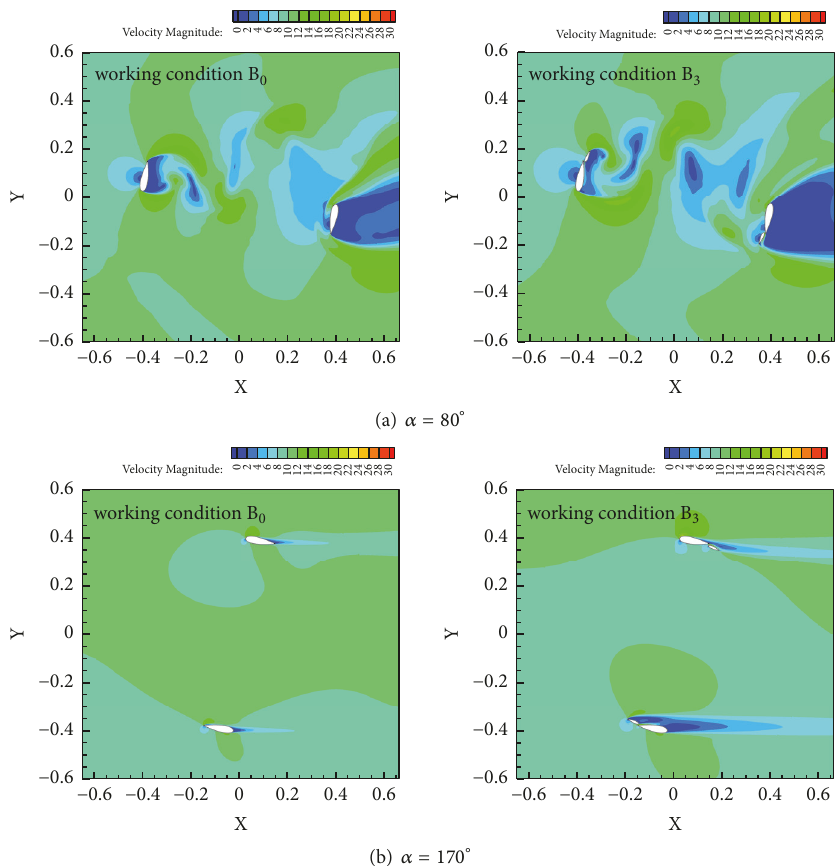
Figure 16: Static velocity contours at two azimuth angles of working condition